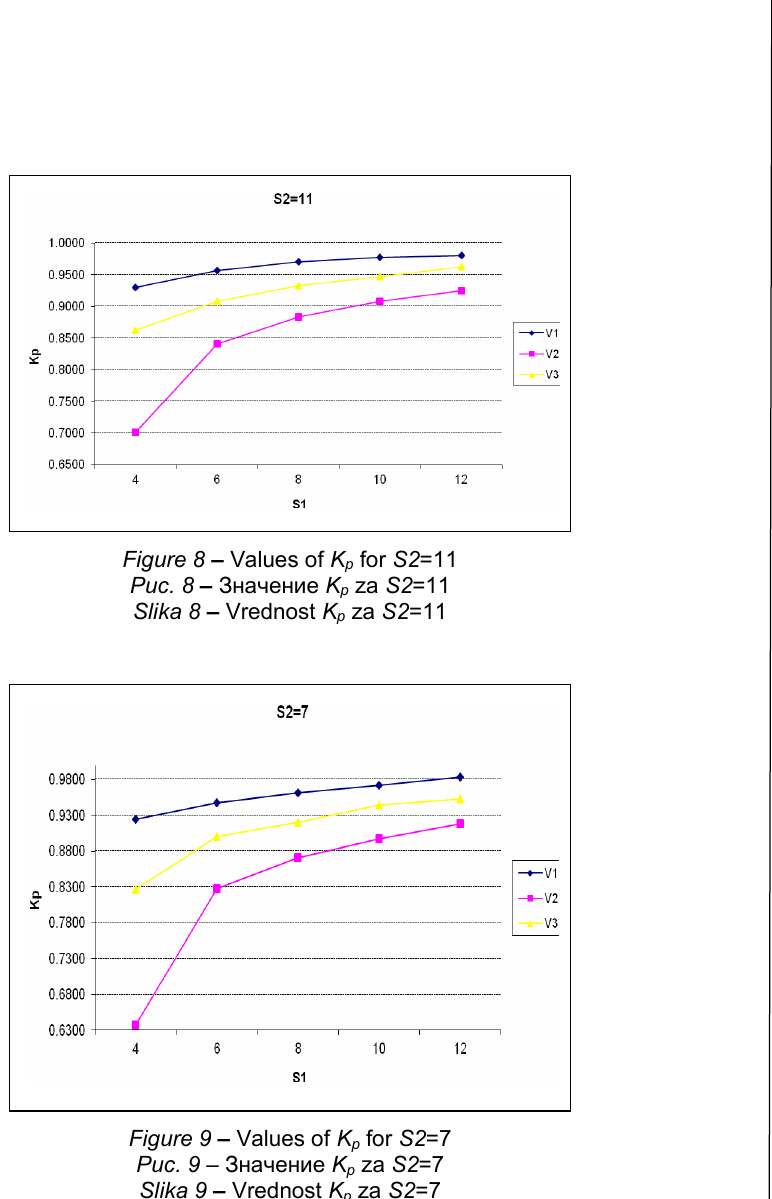
Figure 9 – Values of K p for S2 =7 Рис . 9 – Значение K p za S2 =7 Slika 9 – Vrednost K p za S2